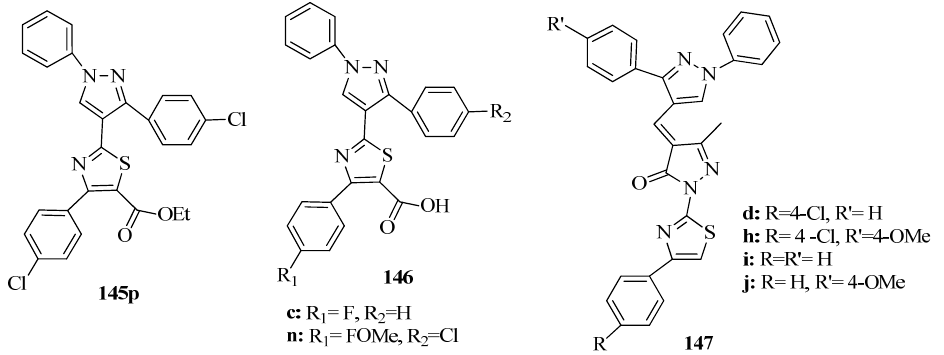
Figure 58. Structure of pyrazolylthiazolecarboxylates ( 145 , 146 ) and thiazole-bearing pyrazole de- rivatives.